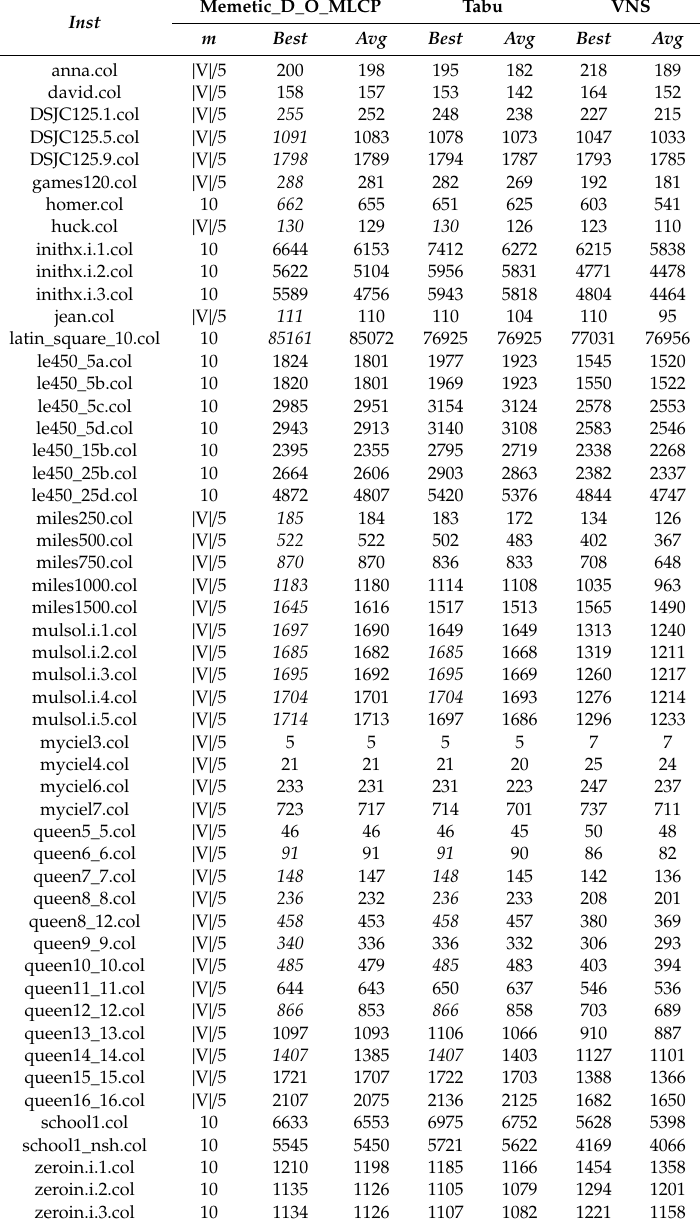
Table 5. Comparison results on Memetic_D_O_MLCP, Tabu and